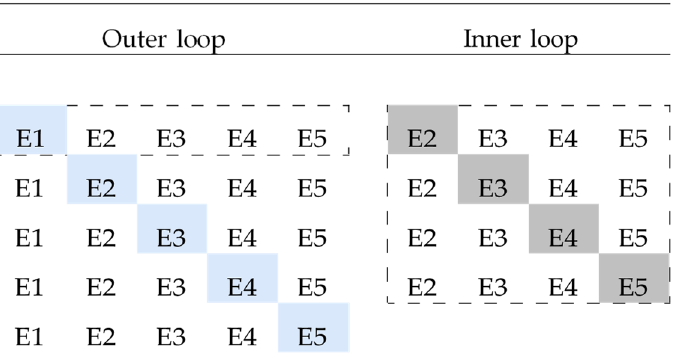
Figure 5. A visual overview of the nested leave-one-experiment-out cross-validation used to optimize and evaluate the artificial neural network. The nested procedure consisted out of an outer loop and inner loop. The hyperparameters were adjusted in the inner loop to optimize a model selection criterion. The weights were adjusted in the outer loop to optimize a model fitting criterion. The visualization is limited to five experiments (E1–E5). The dashed line denotes that the visualization is given for a single iteration of the outer loop, visualizing the tuning procedure for left-out test experiment E1. For this single iteration of the outer loop, experiment 1 (E1) was left out as a true holdout test set. The remaining experiments (E2–E5) were iteratively used as a holdout validation set to optimize the network hyperparameters in the inner loop. The hyperparameter set that resulted in the lowest mean squared error (MSE) was used to fit the model on all experiments of the outer loop (E2–E5). Lastly, this trained model was used to evaluate the model predictions on the left-out test experiment (E1). This conservative approach ensures separation among model selection, model fitting, and model evaluation.